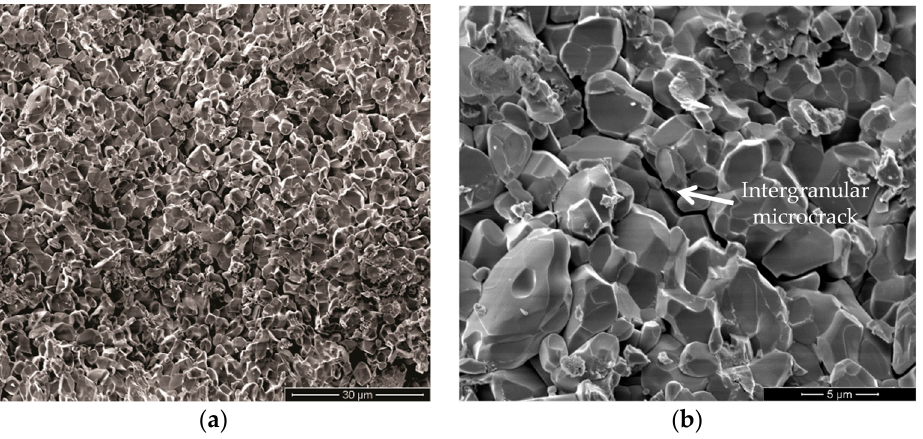
Figure 14. Surface of fracture of the ceramic tablets: ( a ) 3000×; ( b ) 10,000×.